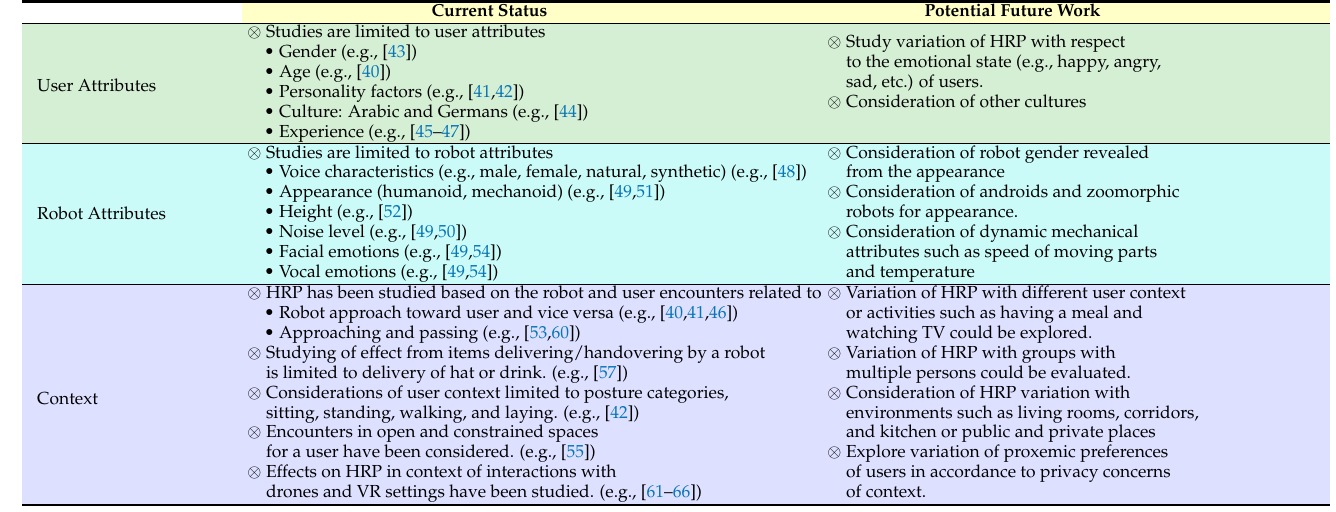
Table 2. Summary of current status and potential future work of HRP explanatory studies.